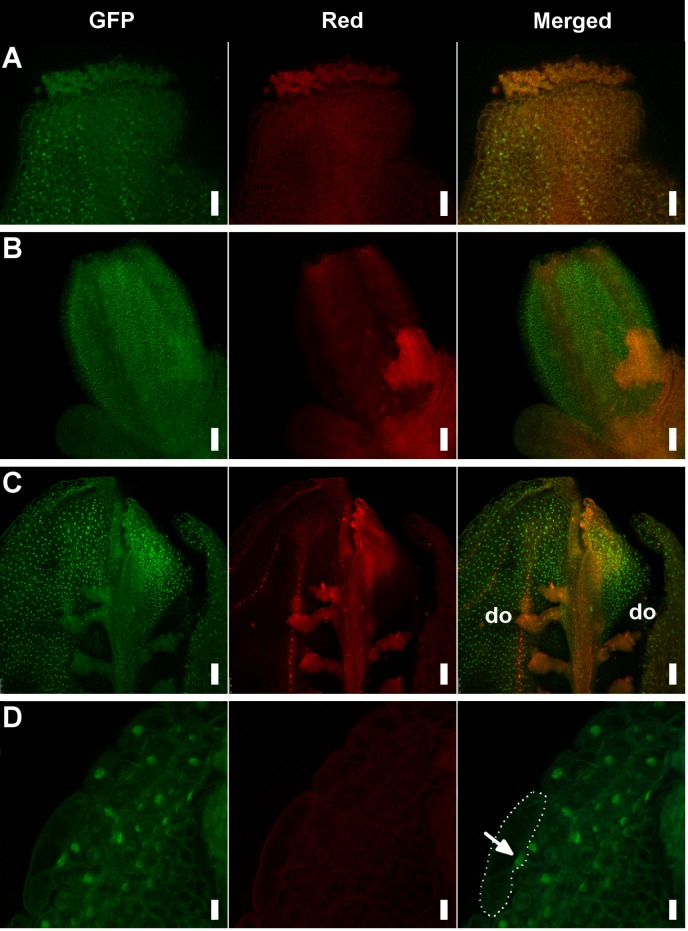
Detection of the AP1-GFP protein in hua1 pep gynoecia.A) Apical region of a mildly affected gynoecium with recognizable pistil morphology. Specific AP1-GFP signal is detected in some style cells. B) Fourth whorl organs of a pre-anthesis flower displaying a severe sepaloid phenotype. C) Adaxial (inner) view of a manually open pistil with severe sepaloid transformations, but containing some developing ovules (do). D) Detail of a fourth whorl organ from panel D showing nuclear-localized AP1-GFP. A cell has been outlined with a dotted line and the nucleus marked with an arrow. Scale bars: 25 μm (A), 50 μm (B and C) and 10 μm (D).